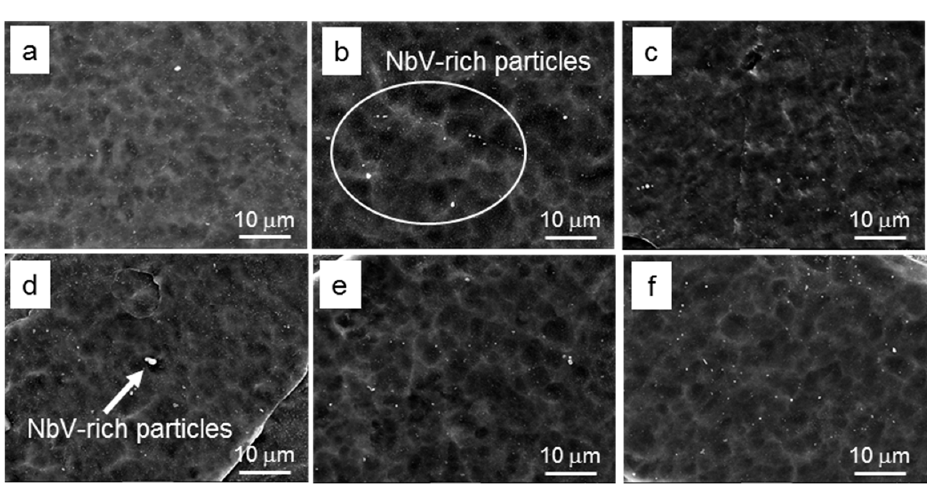
Figure 3. SEM images of ferrite grains showing the Nb- and V-rich particles: ( a ) HFT/600/15, ( b ) HFT/650/15, ( c ) LFT/600/15, ( d ) HFT/600/30, ( e ) HFT/650/30, ( f ) LFT/600/30.